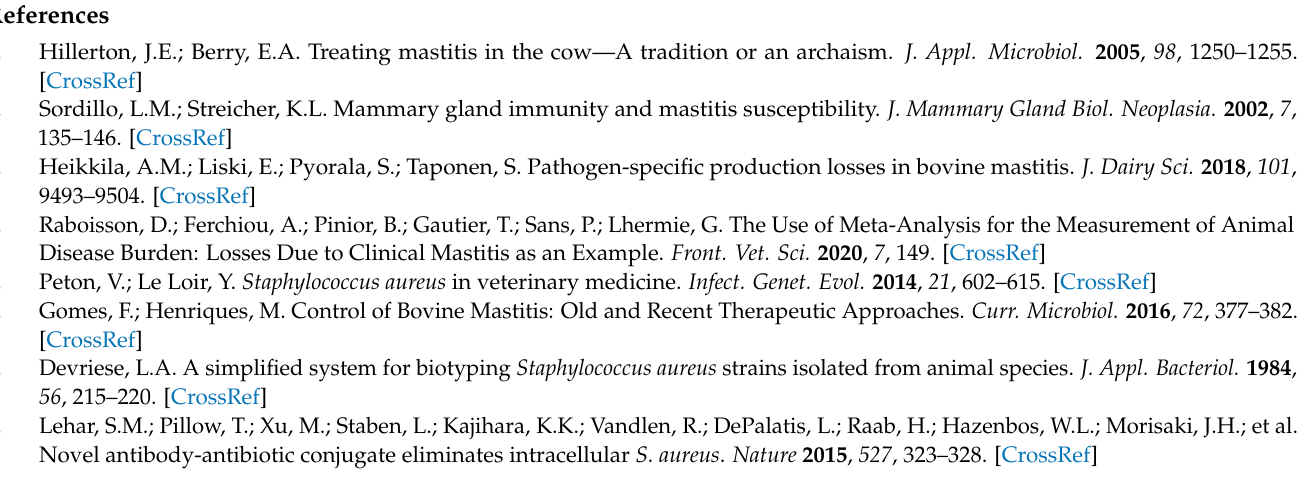
Table S2: Properties of S. aureus